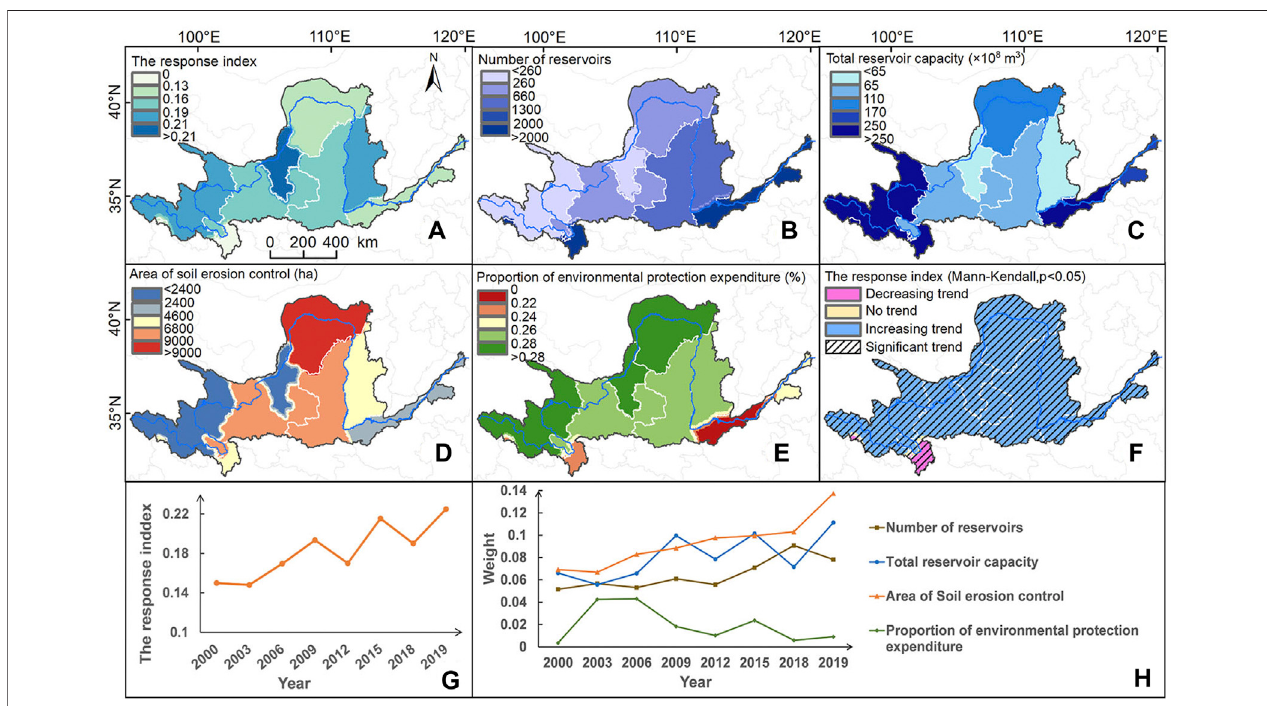
FIGURE4| Spatialdistributionofresponseindex (A) ,spatialdistributionofresponselayerindicators (B – E) ,Mann-Kendalltestresultsofresponseindexatthe0.05 signi fi cance level (H) , time change of stress index (G) , and change of each indicator weight over time trend (H) .